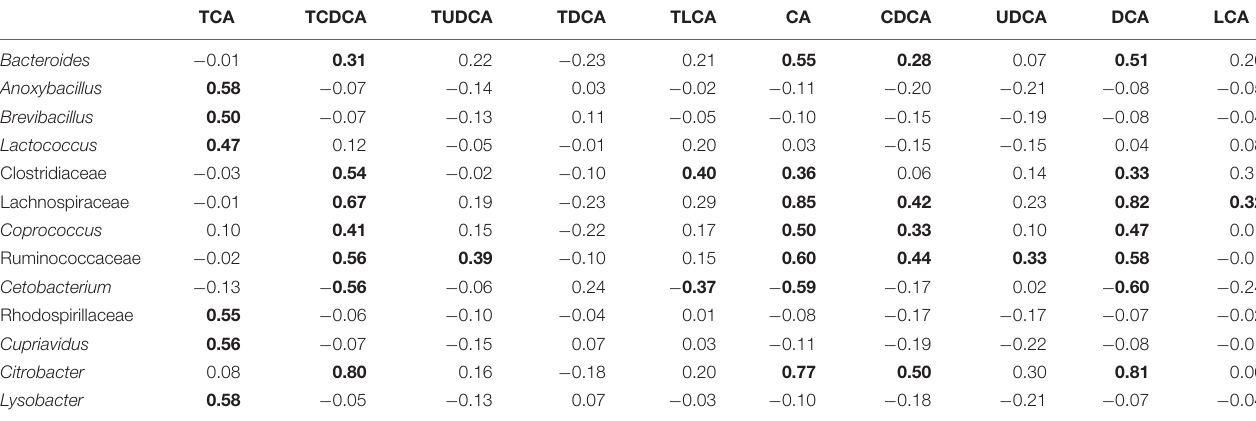
TABLE 2 | Pearson correlations between biliary acids and gut microbiota taxa at the genus level ( r value). TCA TCDCA TUDCA TDCA TLCA CA CDCA UDCA DCA